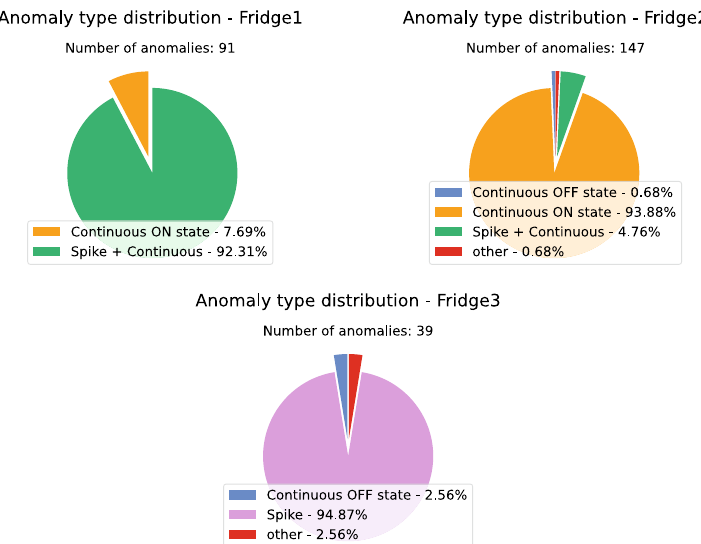
Fig. 4 The anomaly type distribution on the three fridge energy consumption data